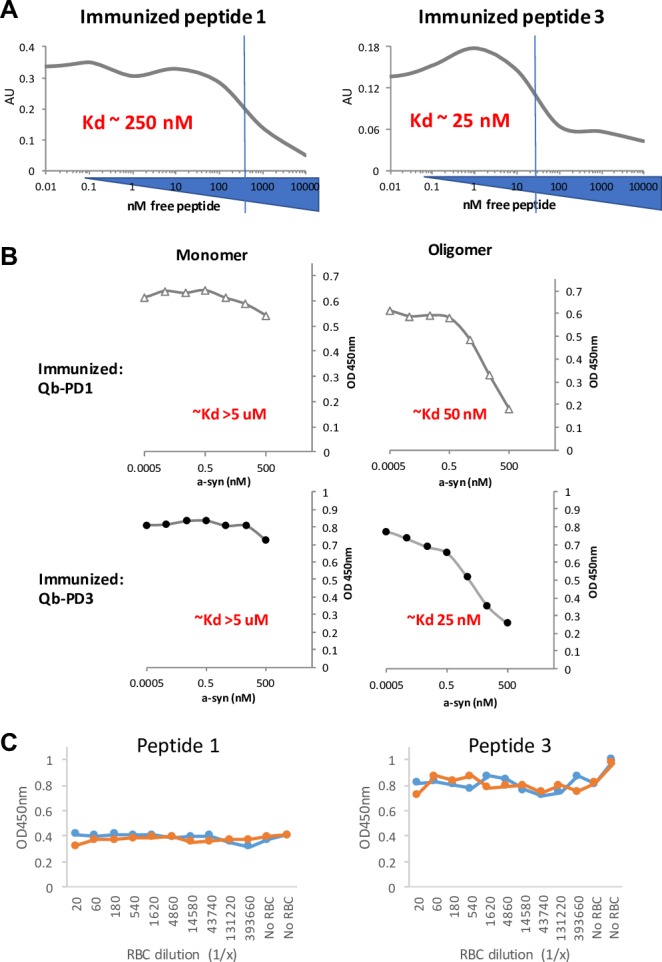
Competition ELISA to estimate relative affinity of vaccine-induced antibodies.Antigens in the form of peptides or recombinant monomer/oligomer protein preparations as described in the methods were coated on to microtitre plates and ELISA reading measured with fixed concentrations of serum IgG antibodies (at OD50 dilution) purified from pooled sera of vaccinated mice (n = 4), preincubated with serial dilutions of (A) free a-syn peptides (PD1, left; PD3, right); (B) free a-syn protein, either monomeric (left panels) or oligomeric (right panels) species, PD1 (top) and PD3 (bottom); and (C) liberated a-syn from haemolysed RBCs (orange line) or PBS negative control (blue line) for PD1 (top) and PD3 (bottom).